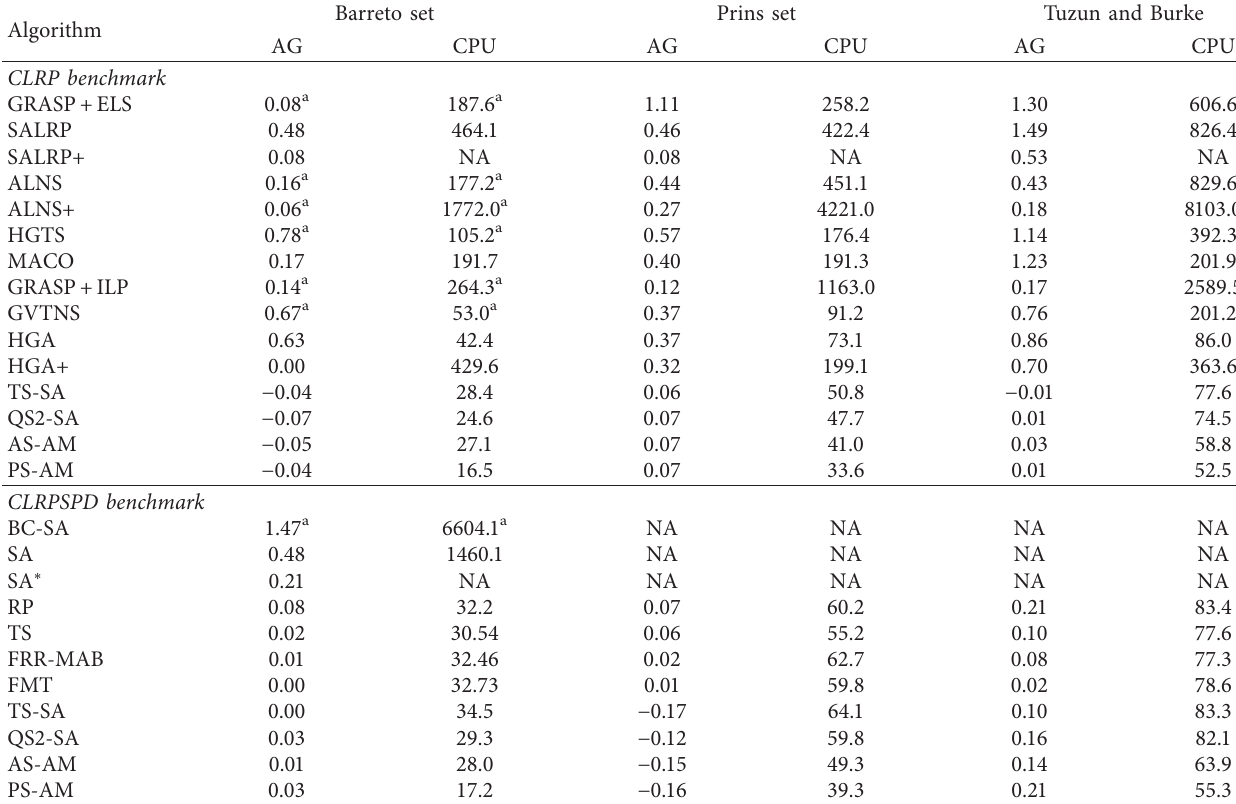
Table 12: Average solutions for CLRP and CLRPSPD benchmark